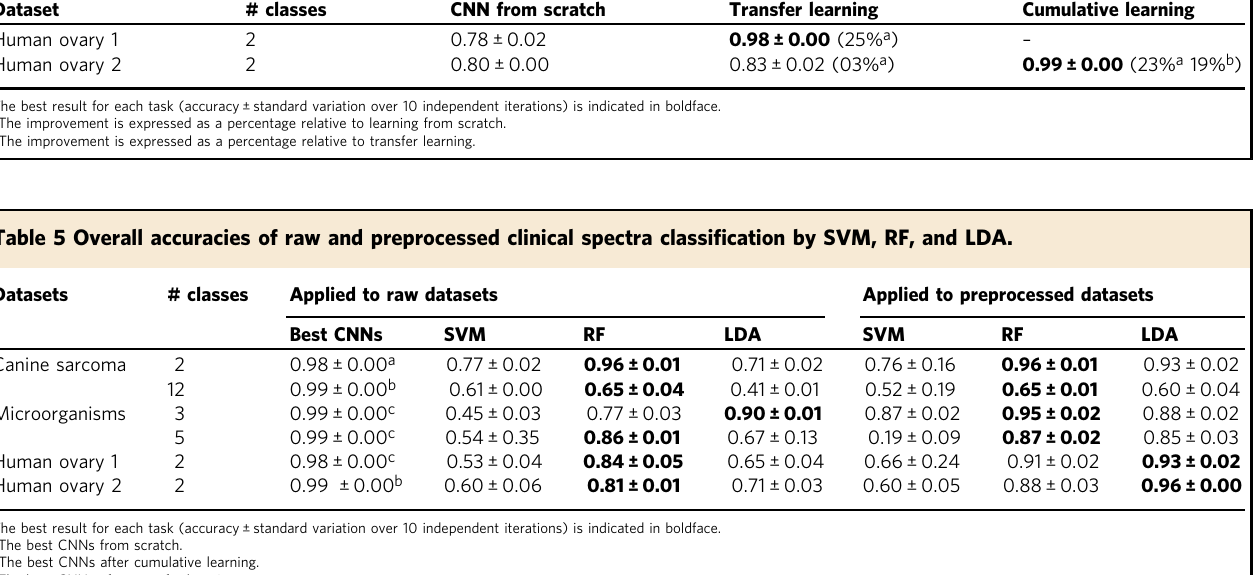
Fig. 1 Work fl ow of CNNs classi fi cation: by transfer learning (in gray for canine sarcoma, microorganisms, and in green for human ovary 1). By cumulative learning Scenario A (in blue for canine sarcoma and in green for human ovary 2). By cumulative learning Scenario B (in orange for canine sarcoma). Final representation of Scenario B is tested on the datasets used during the training (in purple arrows). Table 4 Overall accuracies of variant_LeNet architecture at classifying ovarian spectra. Dataset